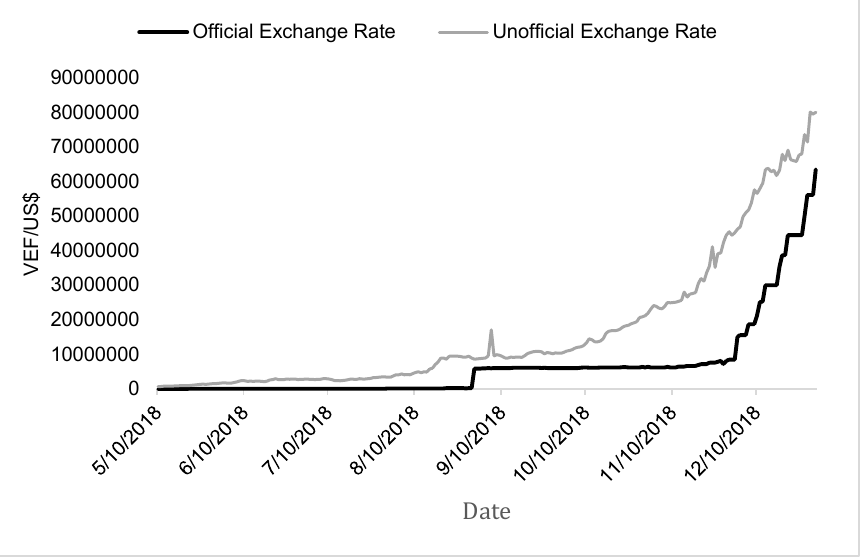
Fig. 4. Venezuelan official and unofficial exchange rates from 10 May 2018 to 31 December 2018 when the Venezuelan government moved to a managed float.